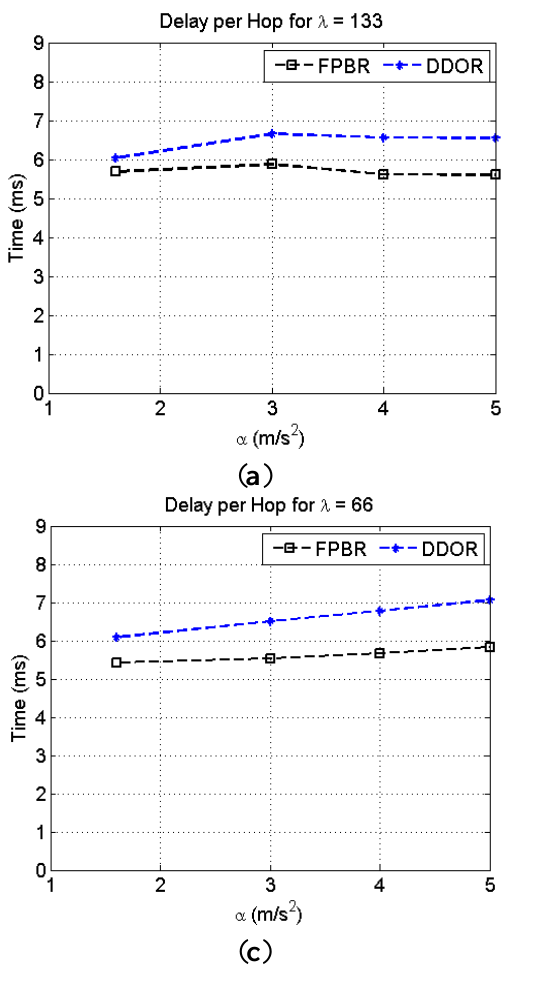
Figure 13. Average delay per hop obtained with FPBR and DDOR when increasing the maximum acceleration, . Four different vehicle densities, , were considered for these plots. Each plot shows the delay per hop vs. α for: ( a ) λ = 133; ( b ) λ = 100; ( c ) λ = 66 and ( d ) λ =